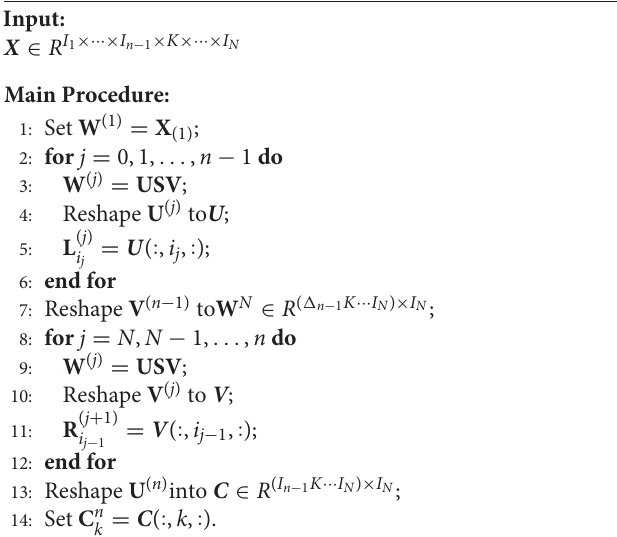
Frontiers in Neurorobotics |